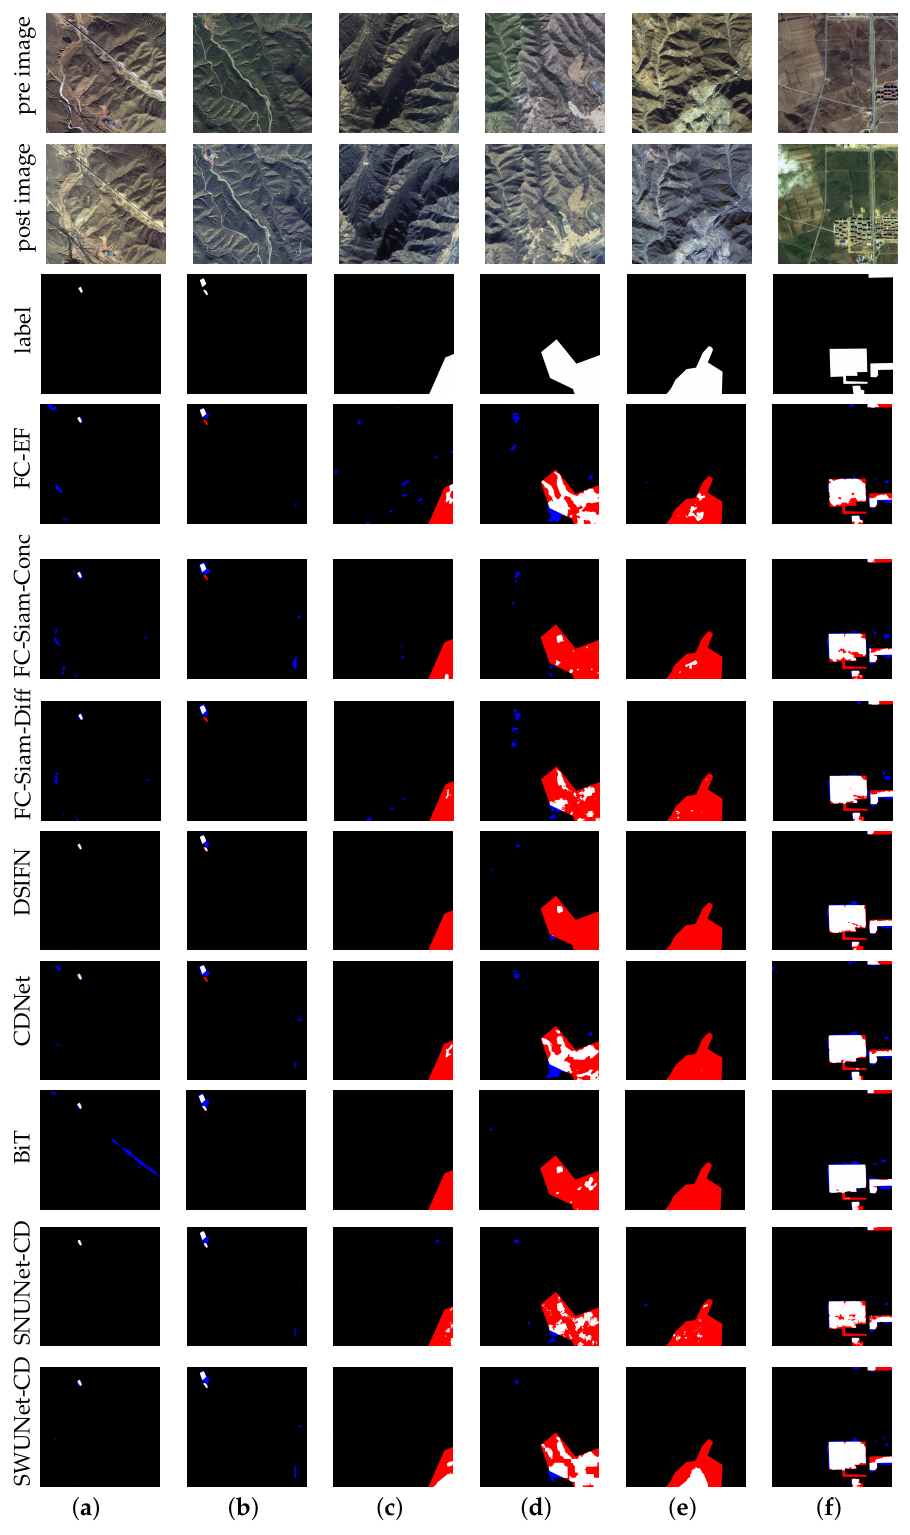
Figure 7. Six groups of images using different change detection networks. ( a ) Buildings in Eco-redline areas. ( b ) Buildings in Eco-redline areas. ( c ) Mines in Eco-redline areas. ( d ) Mines in Eco-redline areas. ( e ) Mines in Eco-redline areas. ( f ) Buildings in rural